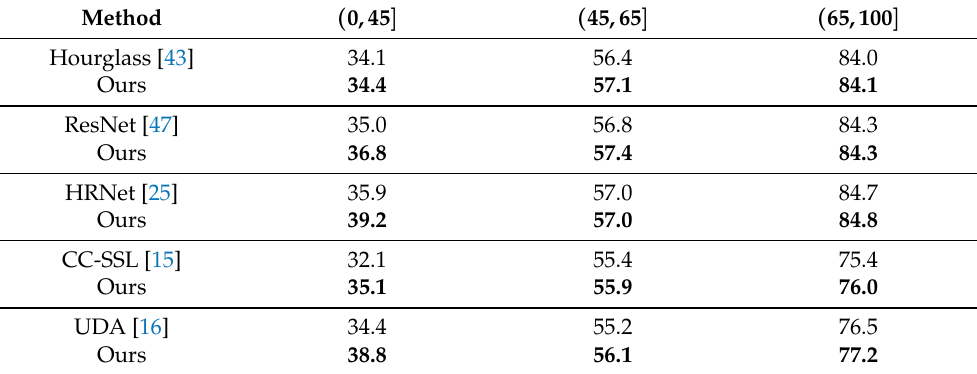
Table 4. PCK@0.05 accuracy on Amur (%). The best results are marked in